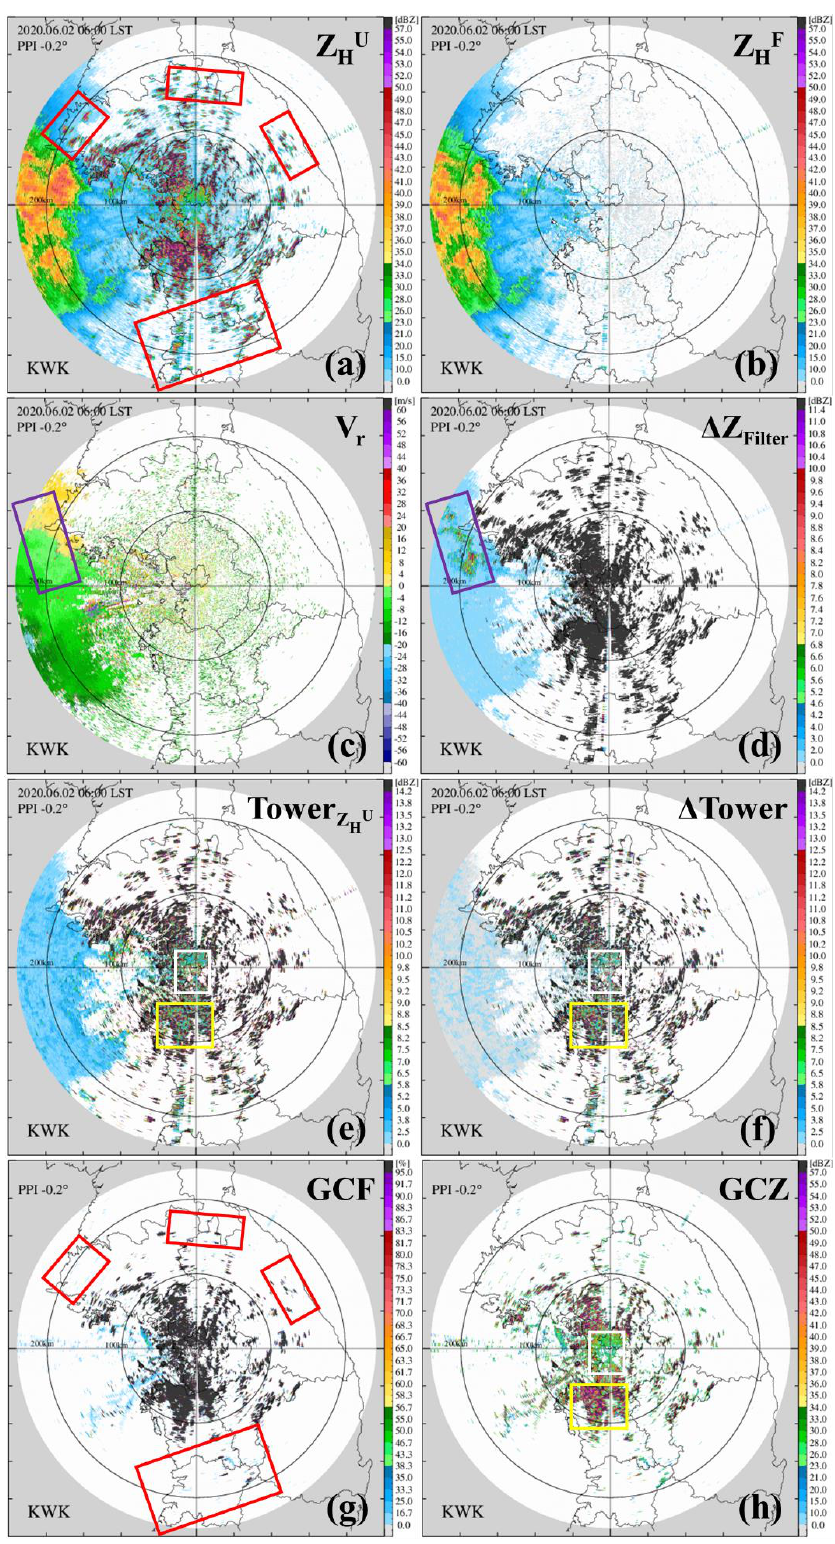
Figure 3. ( a – c ) Observed reflectivity and radial velocity and ( d – h ) corresponding feature parameters of CLEANER for ground clutters of KWK observations at 0600 local standard time (LST) 2 June 2020. Red, purple, white, and yellow boxes indicate ground clutter (GC) due to super refraction, zero isodop, weak GC, and large-clustered GC, respectively.